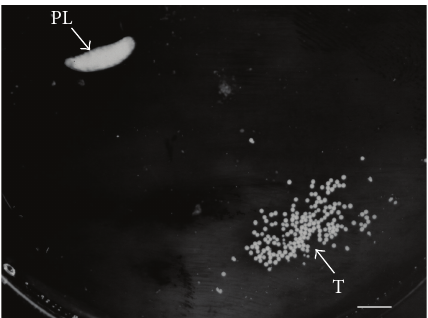
Figure 1: Bright-field image of M. aethiopoides larva and teratocytes collected from a single host adult H. postica hemocoel at approximately seven months after parasitization showing hypertrophied M. aethiopoides teratocytes. PL: parasitoid larvae, T: teratocytes, scale bar = 1mm.